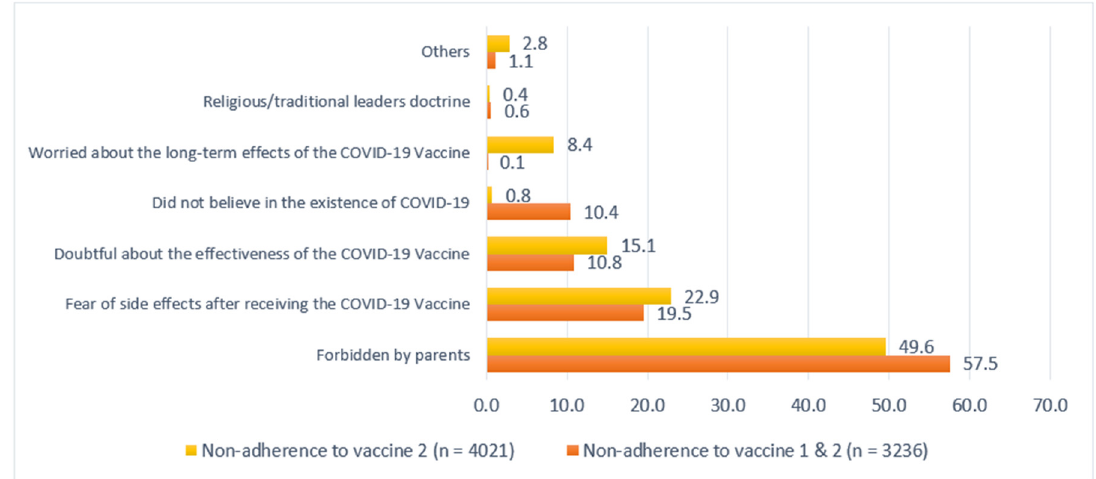
Figure 1. The reasons for vaccine non-adherence among participants.